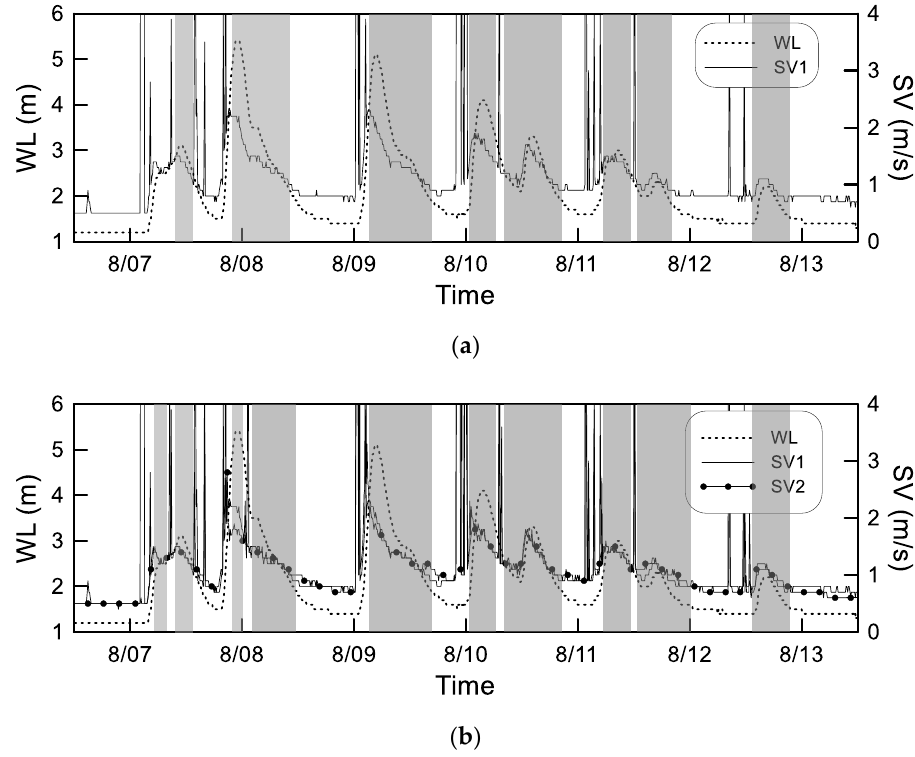
Figure 6. Data sampling examples: ( a ) SV data versus WL; ( b ) SV1 data versus SV2.